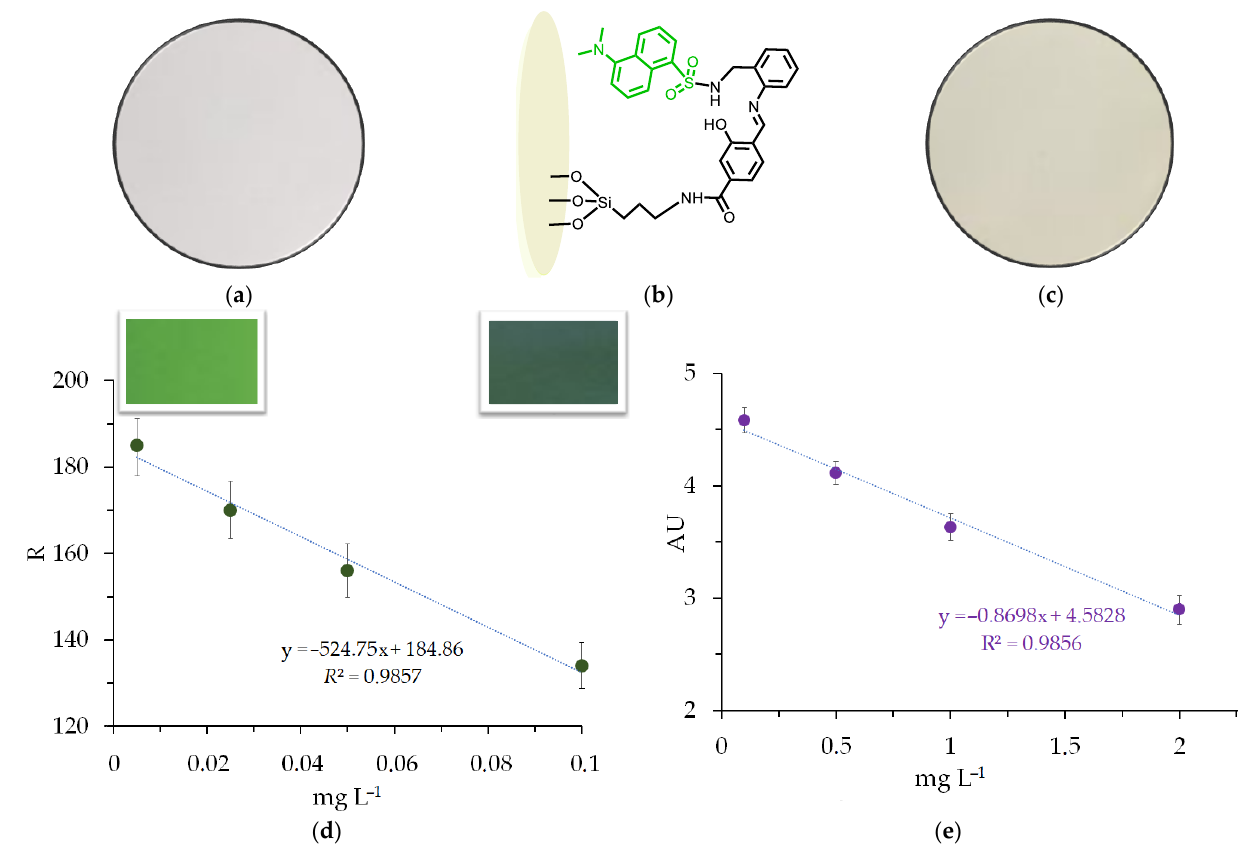
Figure 3. ( a ) Commercial cellulose paper under visible light. ( b ) Schematic representation of the ligand-modified cellulose paper. ( c ) Ligand-modified cellulose paper under visible light. ( d ) Variation of red coordinate in the RGB space of fluorescent images (excitation at 365 nm) of the ligand-modified cellulose paper upon soaking in CdSe-Cys QDs solution (5 – 100 ppb) for 15 min. Images (under UV light) of the fluorescent paper are included to show the color change. ( e ) Decrease in the absorbance of the band at 270 mm, with the increase in CdSe-Cys QDs concentration from 100 ppb to 2 ppm. Since slight color changes cannot be easily observed with the naked eye, we digitized the color information (RGB value) of photographs corresponding to the paper under UV exciting radiation for analysis through the color recognizer application of a smartphone [28,29].